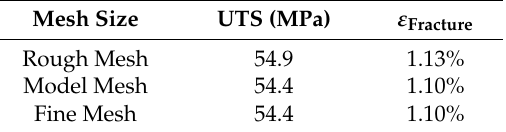
Table 3. Mesh Variability Results.